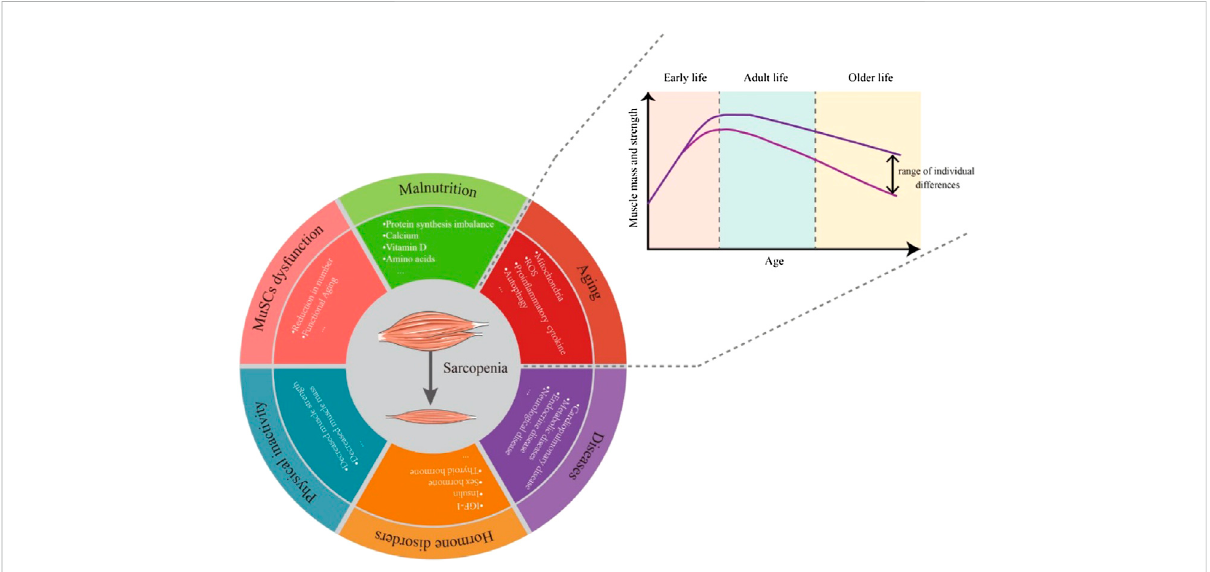
FIGURE 1 Over a lifetime, the body ’ s muscle mass and strength peaks in adulthood and then gradually declines with aging. The rate of decline varies between people with different lifestyles. The causes of sarcopenia include but are not limited to aging, malnutrition, MuSC dysfunction, physical inactivity, hormone disorders and